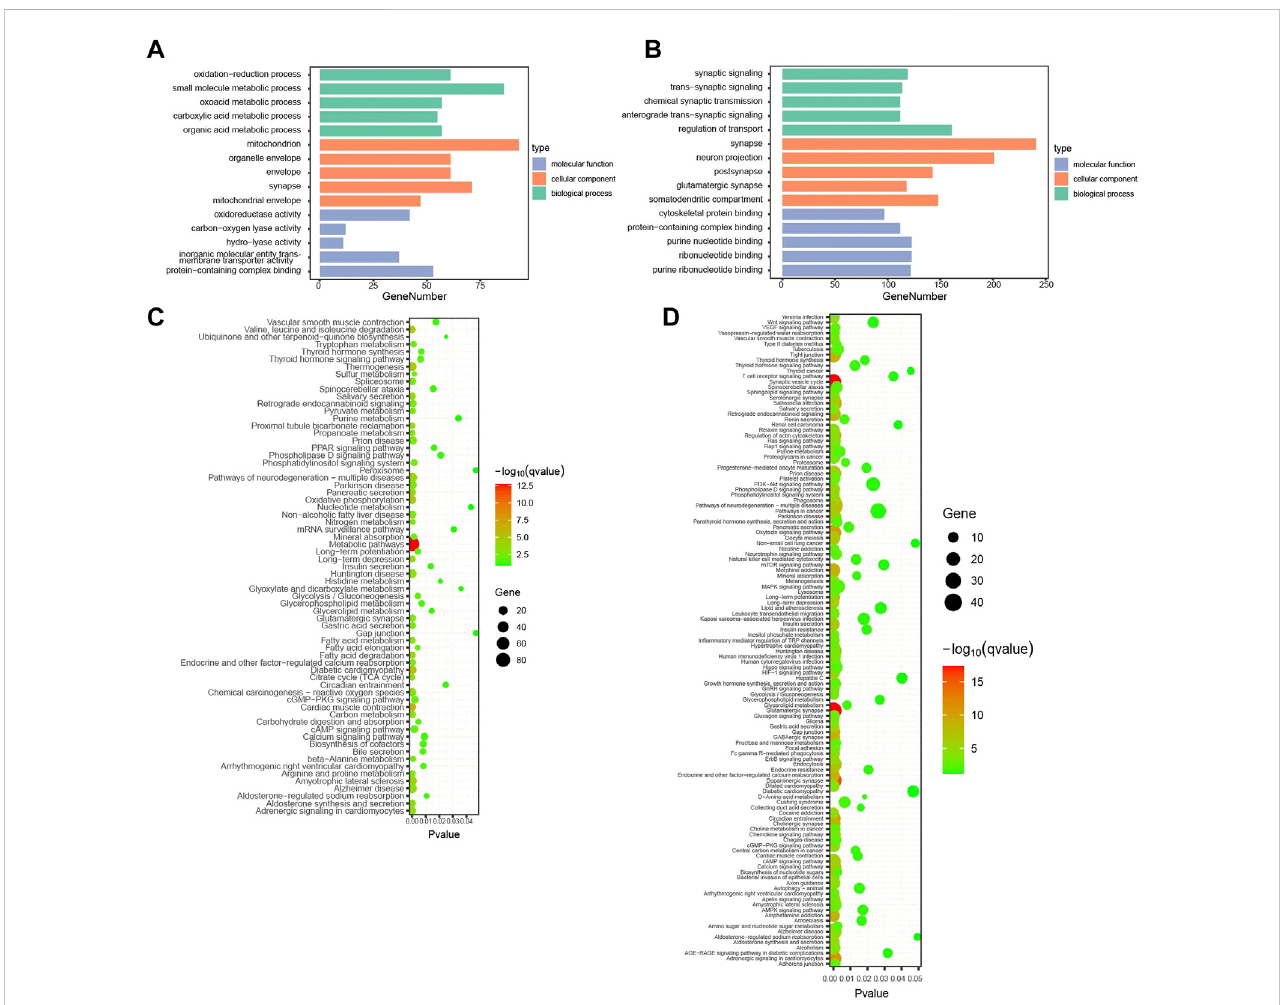
FIGURE 4 Enrichment analysis of withdrawal-related turquoise and blue modules. (A) Top 15 GO functional annotations in blue module. (B) Top 15 GO functional annotations in turquoise module. (C) KEGG pathway enrichment analysis in blue module. (D) KEGG pathway enrichment analysis in turquoise module.